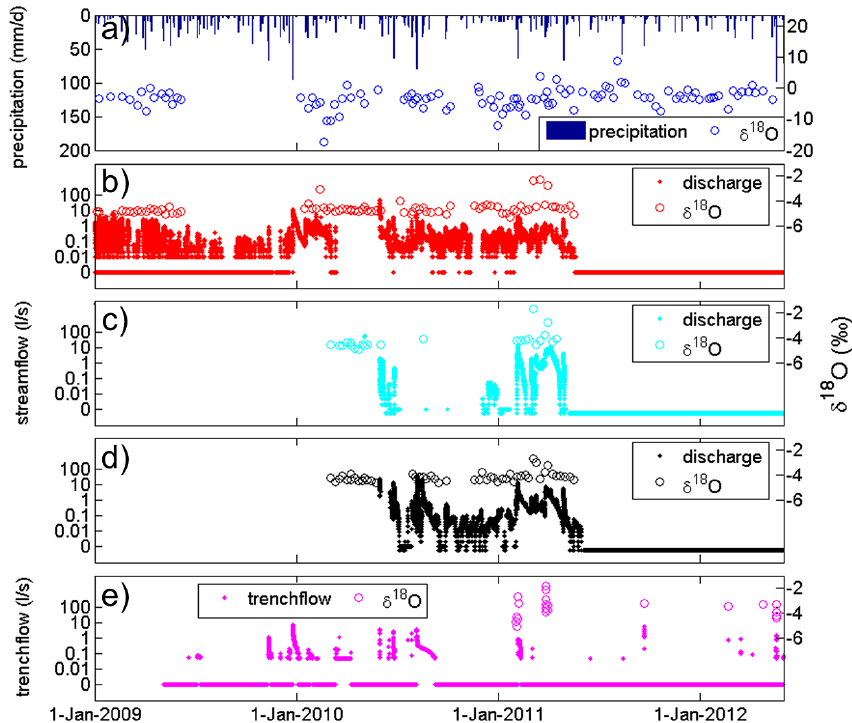
Figure 3. (a) Daily precipitation amount and δ 18 O of precipitation; (b) streamflow and δ 18 O in the R watershed; (c) streamflow and δ 18 O in the B watershed; (d) streamflow and δ 18 O in the C watershed; (e) trenchflow and δ 18 O in the hillslope trench of the R